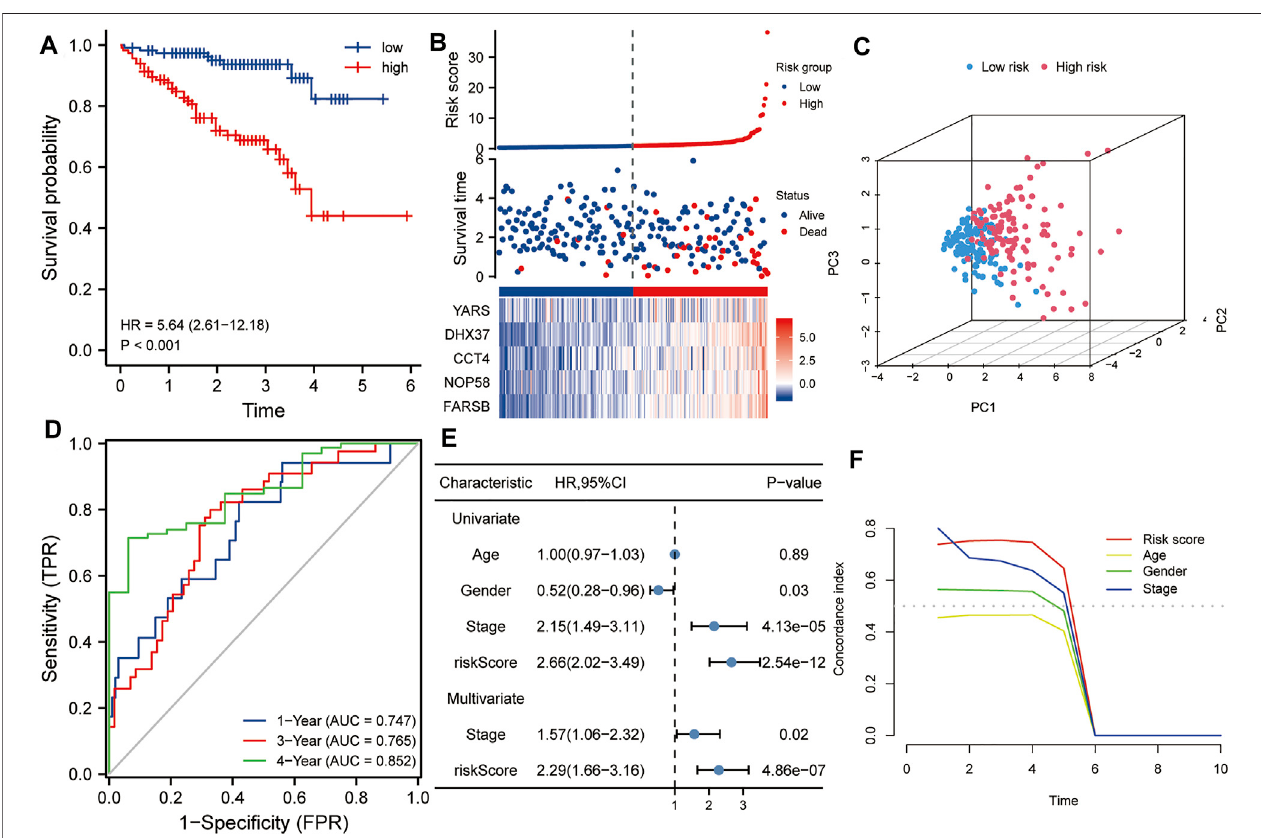
FIGURE4| ValidationoftheriskscoreintheICGCdataset. (A) Kaplan-MeieranalysisshowedthatHCCpatientswithhigherriskscoreshadaworseoverallsurvival rate. (B) The risk score distribution, survival pro fi le and heat map of patients in the high- and low-risk groups in the ICGC dataset. (C) Principal component analysis suggested that the risk score in the ICGC data set was a new dimension for evaluating the prognosis of patients. (D) The ROC curve shows the survival prediction ef fi ciency of the risk score in the ICGC data set (AUC > 0.74). (E) Univariate and multivariate Cox regression analysis showed that risk score is an independent risk factor for OS in HCC patients. (F) tROC analysis showed that the predictive power of risk score was signi fi cantly higher than other clinical characters. HR, hazard ratio; OS, overall survival; tROC, time-dependent receiver operating